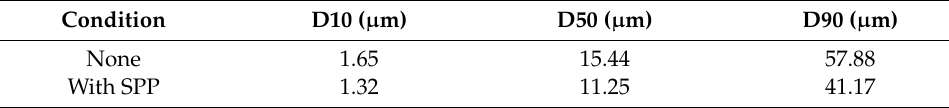
Table 2. The grain size parameters of samples.